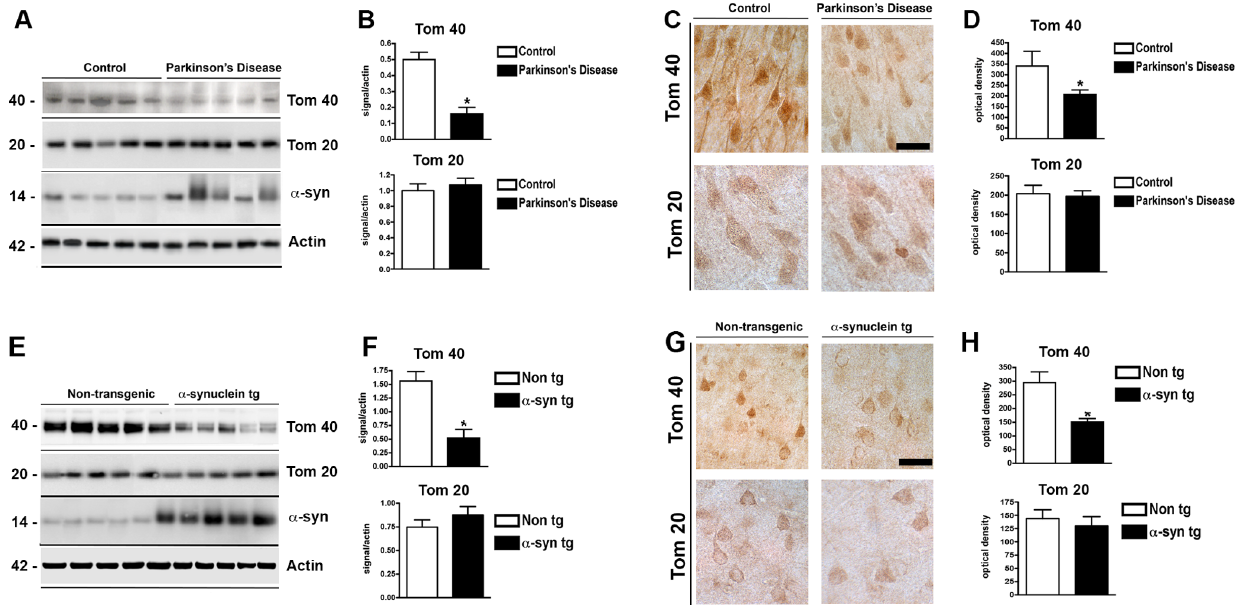
Figure 1. TOM40 protein levels are decreased in PD brains and in a -Syn transgenic mice. (A) Western blot analysis showing levels of mitochondrial proteins TOM40 and TOM20 as well as of a -Syn on postmortem human brain samples from control subjects and PD patients ( b -Actin signal is shown as normalization control). (B) Densitometric analysis of TOM40 and TOM20 immunoreactivity. (C) Immunohistochemical detection of TOM40 and TOM20 in control and PD brains. (D) Optical density analysis of TOM40 and TOM20 immunoreactivity. (E) Western blot analysis of Tom40, Tom20 and human- a -Syn levels on whole brain homogenates from a -Syn-tg mice and non-transgenic littermate controls. (F) Densitometric analysis of Tom40 and Tom20 on mice brains. (G) Immunohistochemical detection of Tom40 and Tom20 in a -Syn-tg and non-transgenic mice. (H) Optical density analysis of Tom40 and Tom20 on mice brains. *p , 0.05 per Student’s t test. Scale bar represents 25 m m.